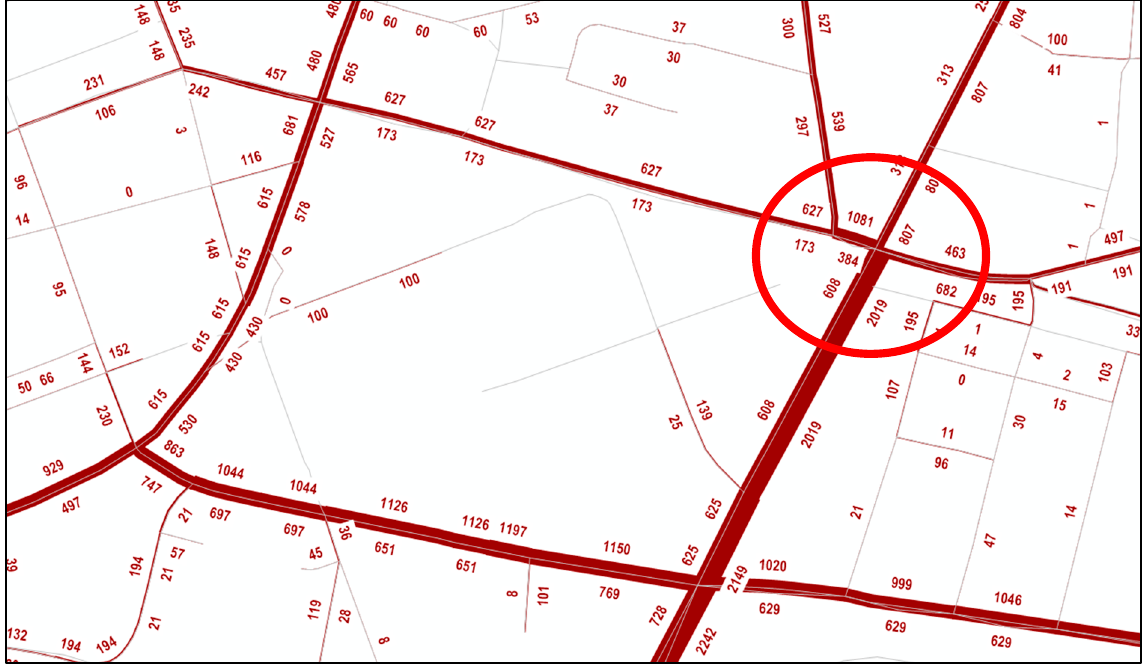
Figure 9. Example of a traffic model scenario for the new city centre of Bratislava.